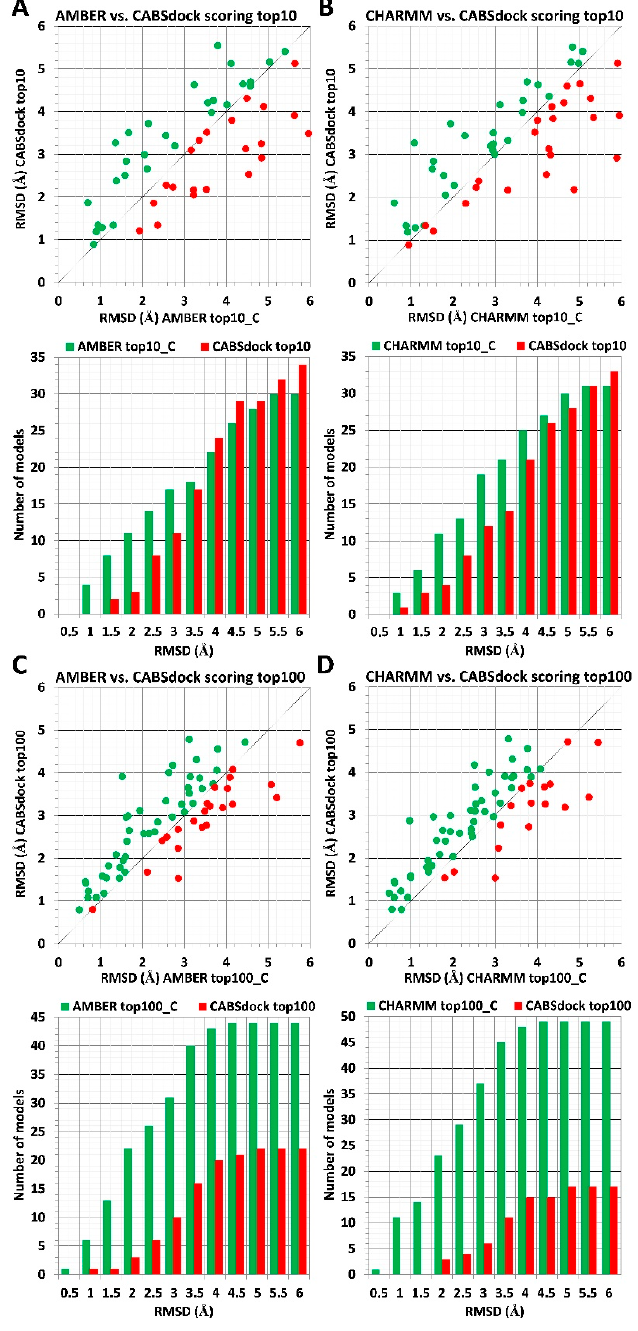
Figure 3. Comparison of MD-based versus CABS-dock scoring after substitution of a protein receptor with its crystal structure. The scoring data for 66 different protein–peptide complexes is shown. MD-based scoring was performed using two different force fields: AMBER and CHARMM. Interaction energy for each complex model was calculated using receptor–protein conformation derived from its crystal structure used in the CABS-dock benchmark (see Materials and Methods section for details). Panels ( A , B ) show results obtained for sets of top 10 models, and panels ( D , F ) show results for sets of top 100 models. The plot at the top of each panel ( A – D ) shows RMSD values for best rank models according to the MD scoring method (color green) vs. RMSD values obtained for CABS-dock models (color red). At the bottom of each panel, the bar plot shows numbers of models with lower RMSD values identified using either the MD scoring method (color green) or using the CABS-dock scoring scheme (color red) for 0.5 A intervals.